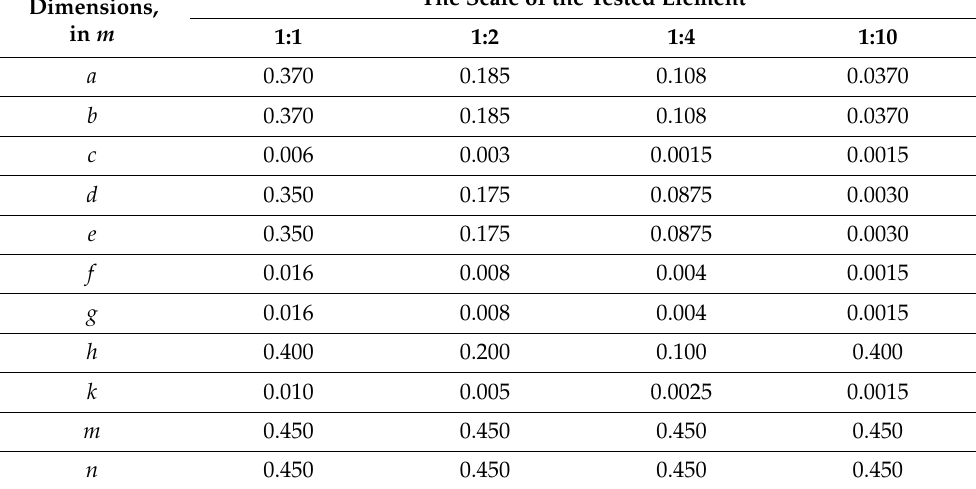
Figure 2. The tested structural elements’ sizes [1,56,64]. Table 1. The structural elements’ sizes [1,56,64].